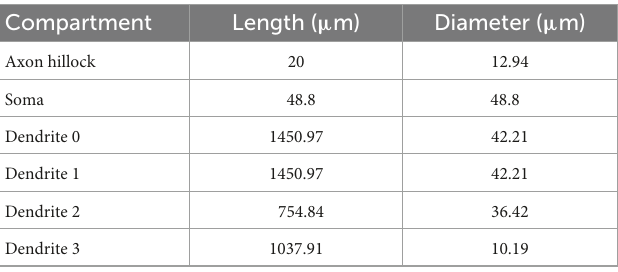
TABLE 1 Geometric properties of the (6C) reduced control model.